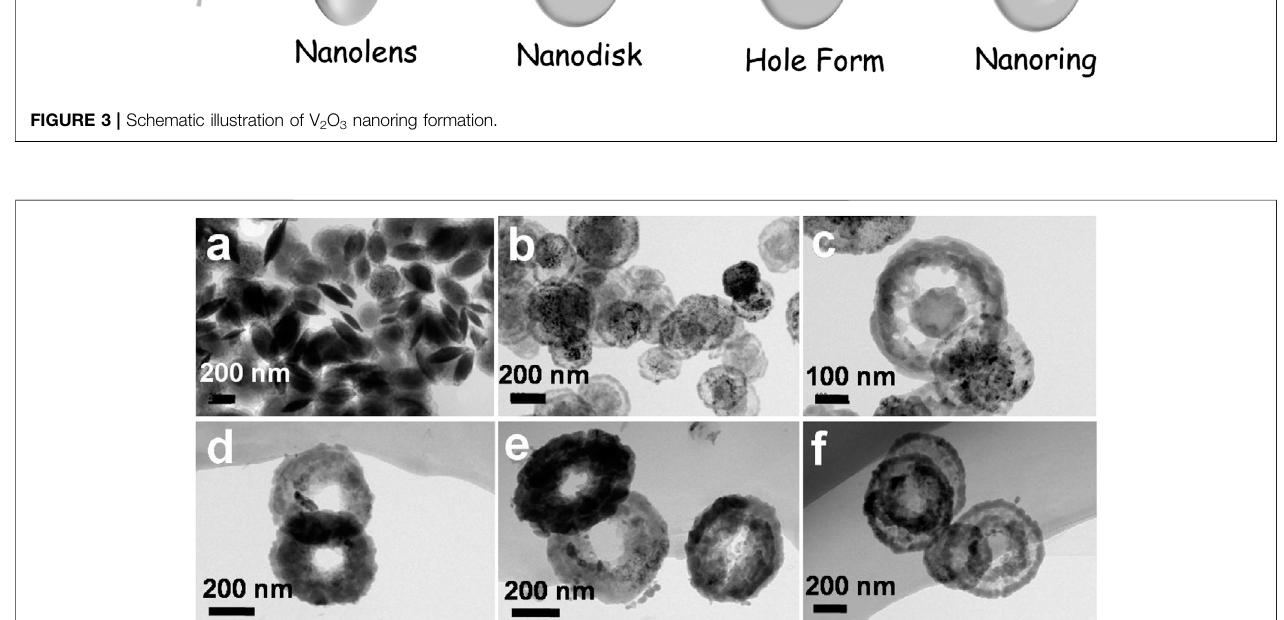
FIGURE 4 | The formation process of the V 2 O 3 nanorings, (A) < 2 h, (B) 2 h, (C) 3 h, (D) 4 h, (E) 6 h, (F) 8 h.